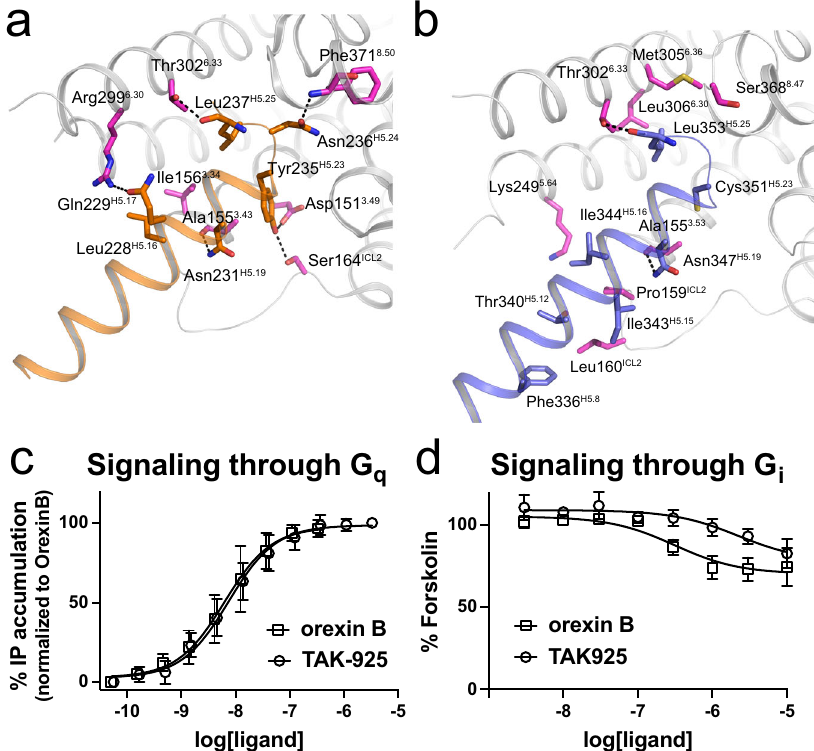
Fig. 5 Interfaces of OX 2 R-G protein complexes and activation of G i and G q . a Interactions within 4 Å between OX 2 R and mG sqiN (gray cartoon and purple sticks for OX 2 R and orange cartoon and sticks for H5 helix of G q α subunit). Hydrogen bonds are dotted lines. b Interactions within 4 Å between OX 2 R and G i1 (gray cartoon and purple sticks for OX 2 R and blue cartoon and sticks for H5 helix of G i α subunit). Hydrogen bonds are dotted lines. c G q signaling mediated by OX 2 R with TAK-925 or orexin B. Each data point represents an average from n ≥ 3 independent experiments (each performed in duplicate), where n is shown in Supplementary Table 2. Error bars are ±SD. Data were normalized to the orexin B E max and fi tted to the three-parameter model ‘ log(agonist) vs response ’ in GraphPad Prism 9. Source data are provided as a Source Data fi le. d G i signaling mediated by OX 2 R with TAK-925 or orexin B. Each data point represents an average from 3 independent experiments (each performed in duplicate). Error bars are ±SD. Source data are provided as a Source Data fi